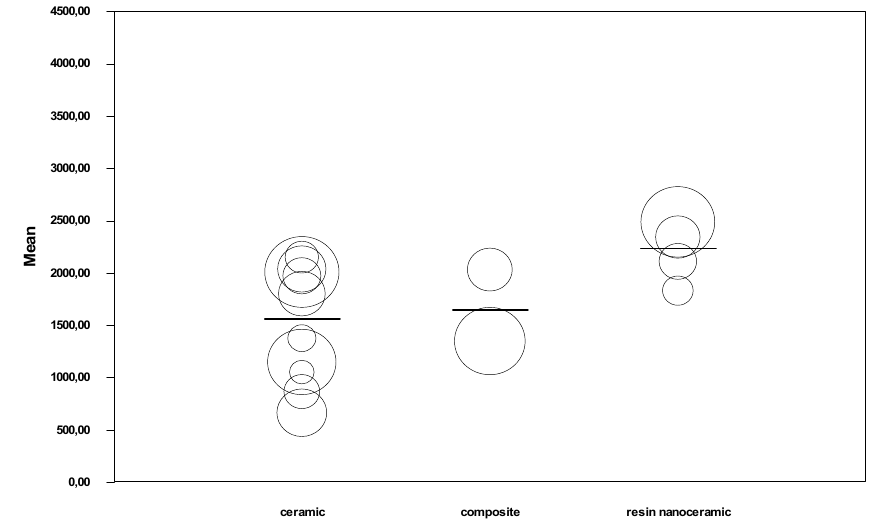
J. Clin. Med. 2019 , 8 , x FOR PEER REVIEW Figure 6. Regression model of mean fracture resistance by restoration type. Figure 6. Regression model of mean fracture resistance by restoration type.